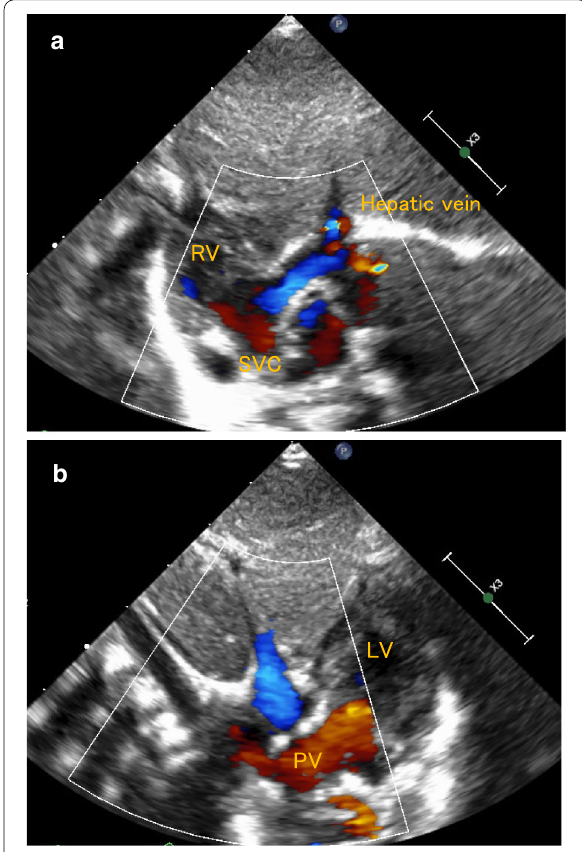
Fig. 3 a , b The transthoracic echocardiography taken after Mustard operation showed that the systemic venous flow routed to the right-sided atrium through the systemic venous baffle, whereas the pulmonary venous flow was routed to l-A through the pulmonary venous